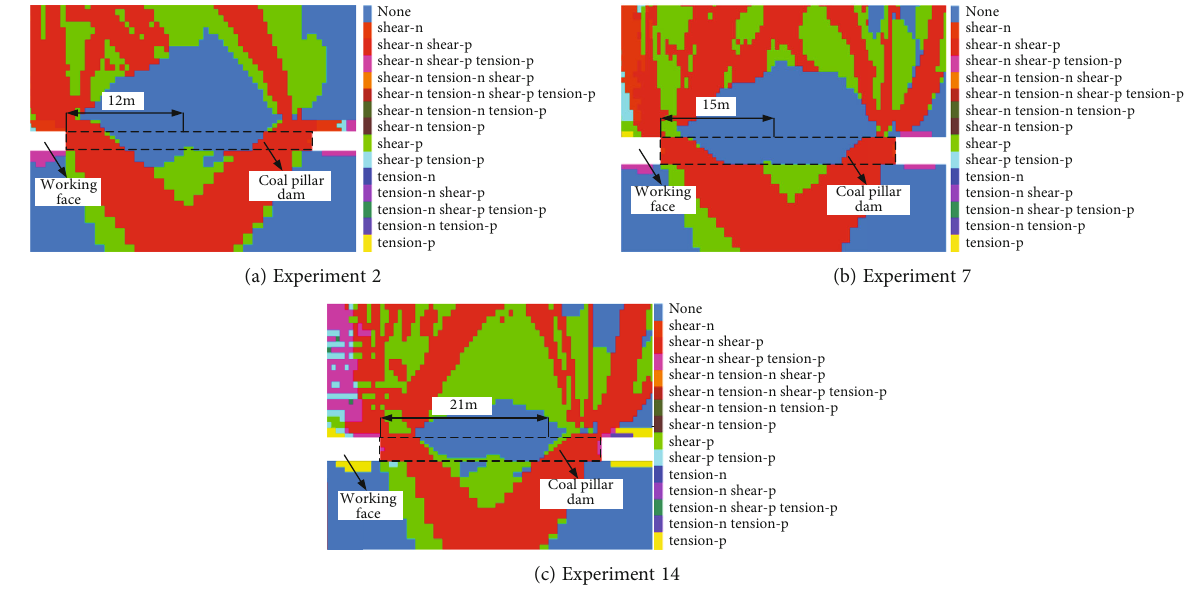
Figure 6: Plastic zone cloud diagram of partial coal pillar dams.